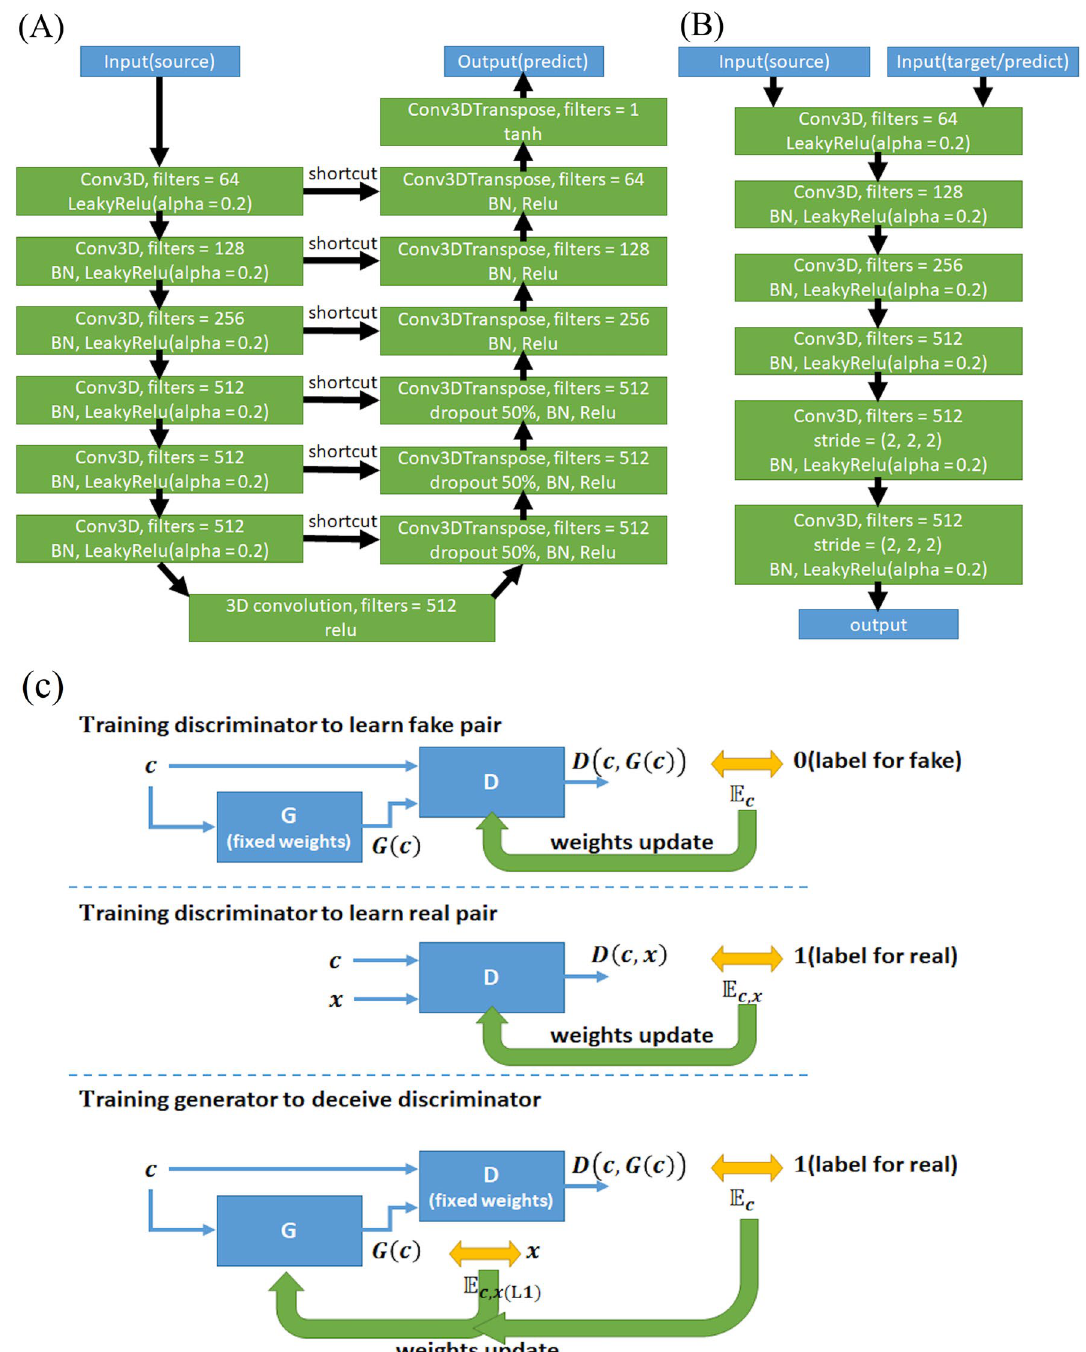
Figure 5. Topology of the pix2pix network. The topology and parameters of the ( A ) U-Net and ( B ) PatchGAN classifiers with two input terminals. The job of the PatchGAN classifier determines whether the two input images are the same pair and the input of the right terminal is the target (real) or prediction (fake). In the first three layers of Conv3DTranspose, dropout can prevent overfitting. “BN” is abbreviation of “BatchNormalization”. ( C ) Framework of the cGAN. The input “c” and “x” represent raw images that are affected by intensity bias and images with bias field correction,